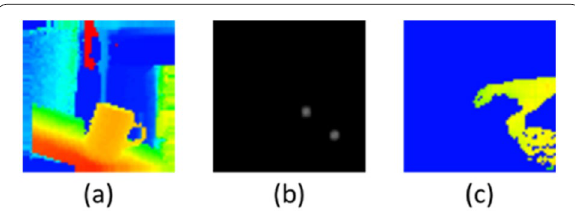
Fig. 3 Effect of the number of output channels of the grasping position network. a The input object shape, b the two-peak heatmap estimated by a network outputting a single channel heatmap, and c the hand shape image estimated from a and b